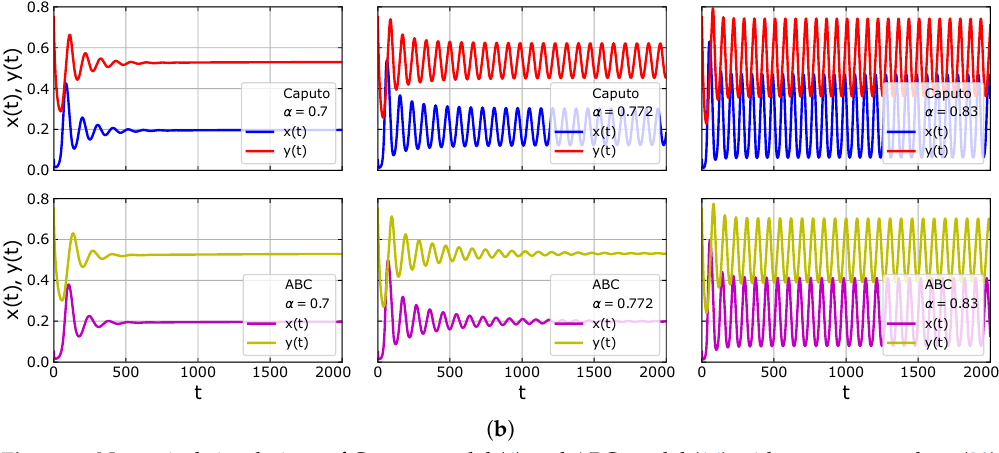
Figure 7. Numerical simulations of Caputo model (6) and ABC model (16) with parameter values (29), n = 0.2, and α = { 0.7,0.772,0.83 } : Figure ( a ) phase portrait; and Figure ( b ) time